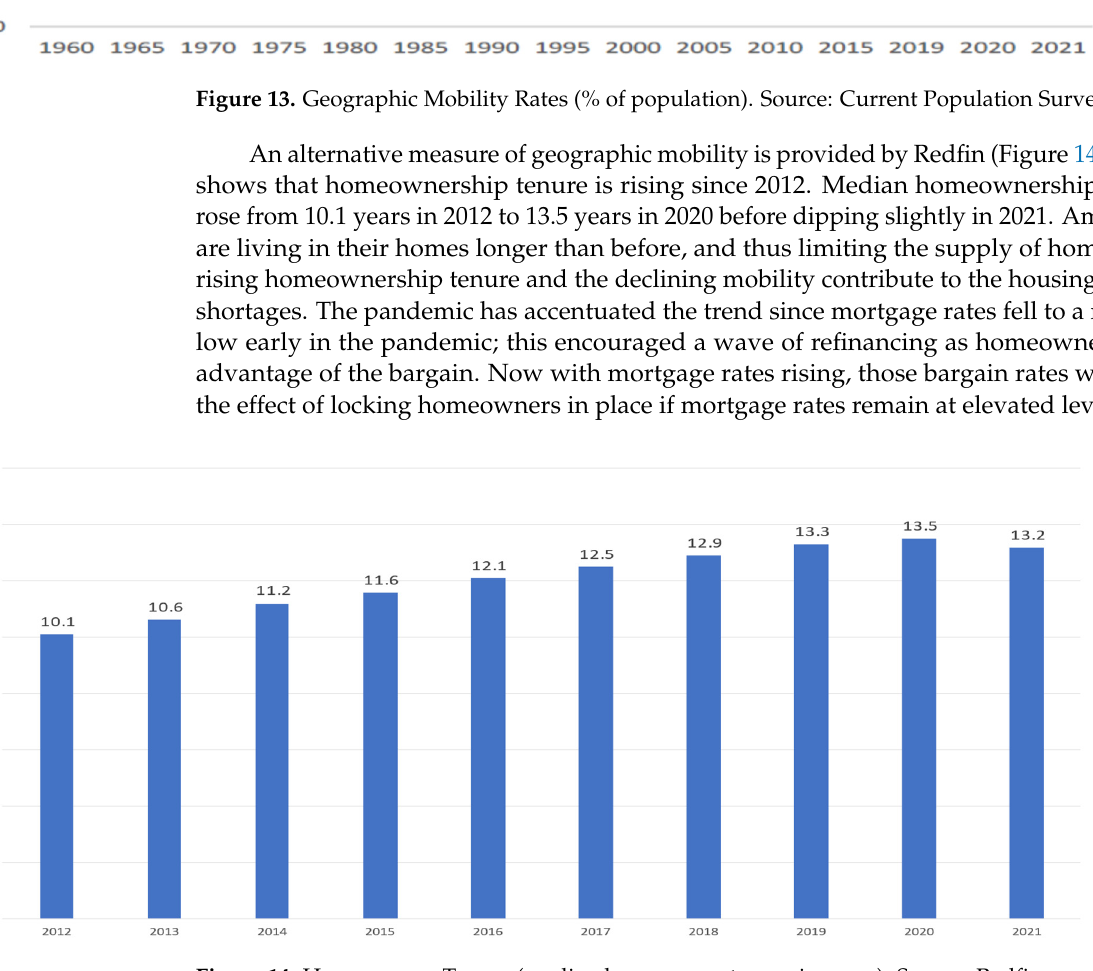
Figure 14. Homeowners Tenure (median homeowner tenure in years). Source: Redfin.